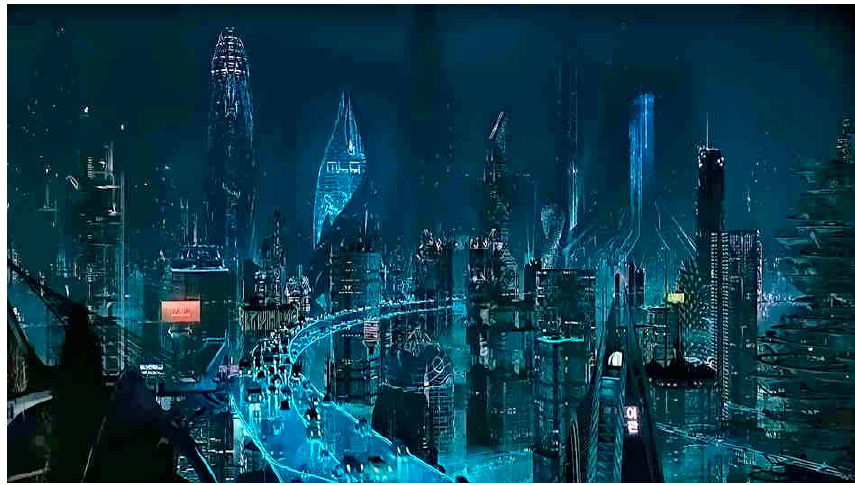
fig. 20. Cloud Atlas neo